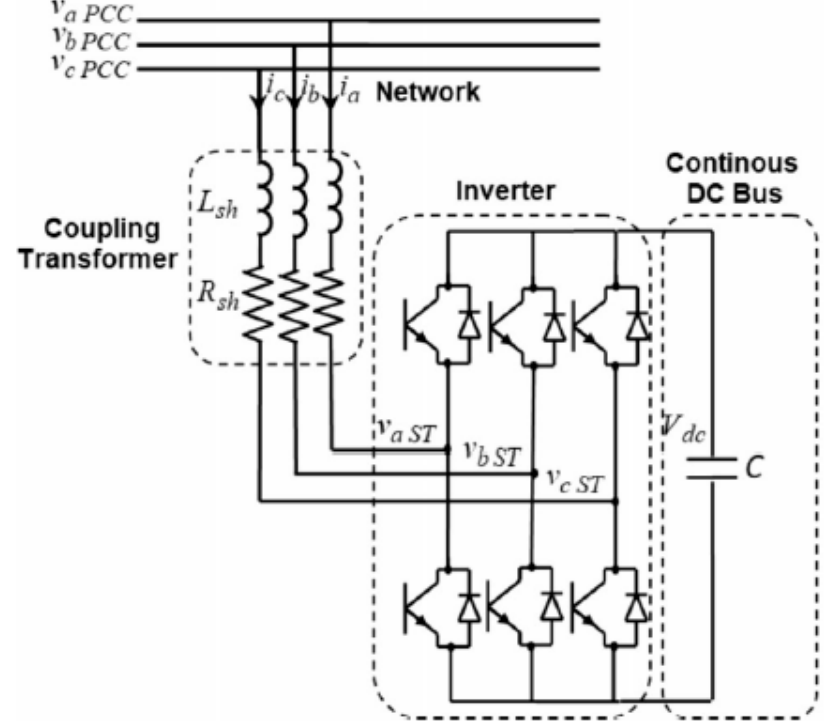
Figure 2. Equivalent circuit of DSTATCOM.